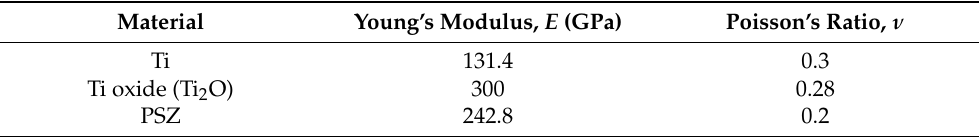
Table 2. Elastic properties of Ti, Ti oxide, and PSZ used for comparing the experimental results with results obtained by DIM.